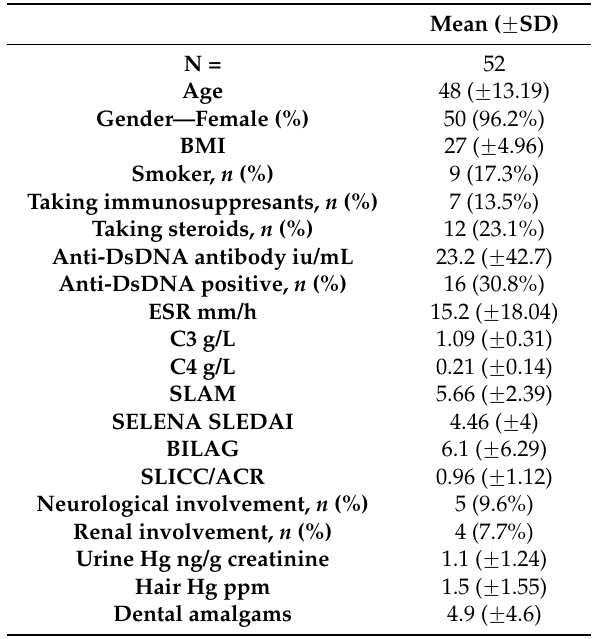
Table 1. Characteristics of systemic lupus erythematosus